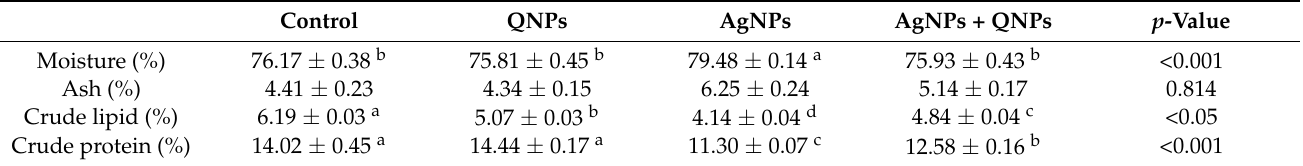
Table 2. Effect of QNPs on whole-body composition (% wet weight basis) in AgNPs-induced toxicity in Nile tilapia.